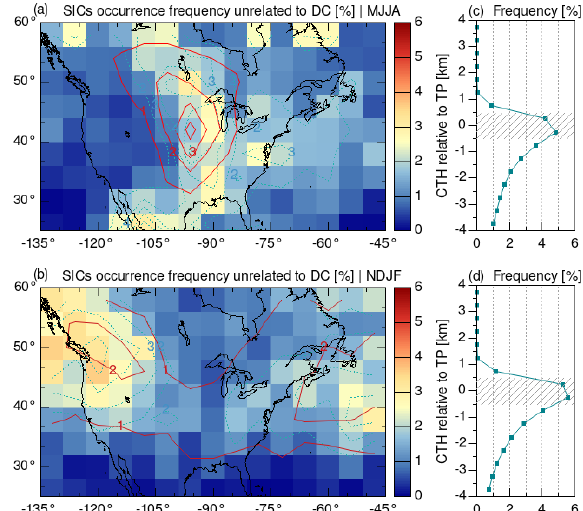
Figure 7. Occurrence frequencies of SIC observations that are not directly related to deep convection for MJJA (a) and NDJF (b) . The red contour lines show the occurrence frequencies of deep convec- tion, and blue dotted contour lines are the occurrence frequencies of SIC. Panels (c) and (d) are the fractions of ice cloud top heights relative to the tropopause, which are not directly related to deep